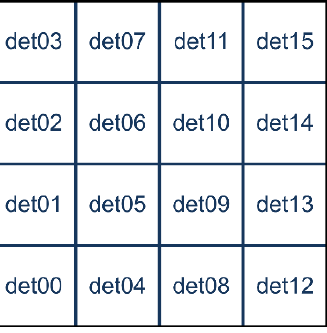
Figure 19. The 4 × 4 arrangement and numbering of the detector positions for the test with fast neutrons.